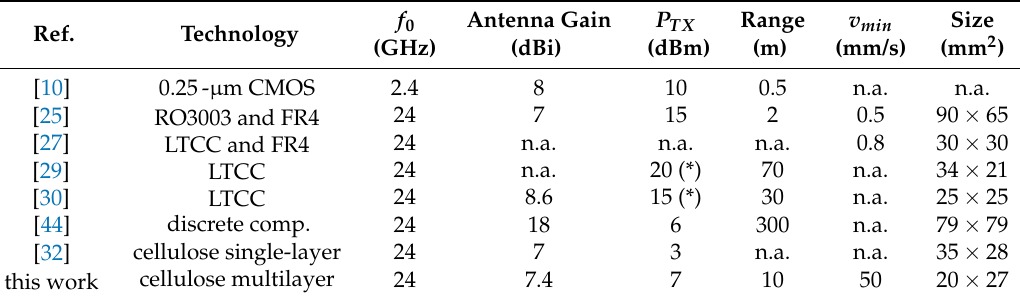
Table 2. State-of-the-art for doppler radar